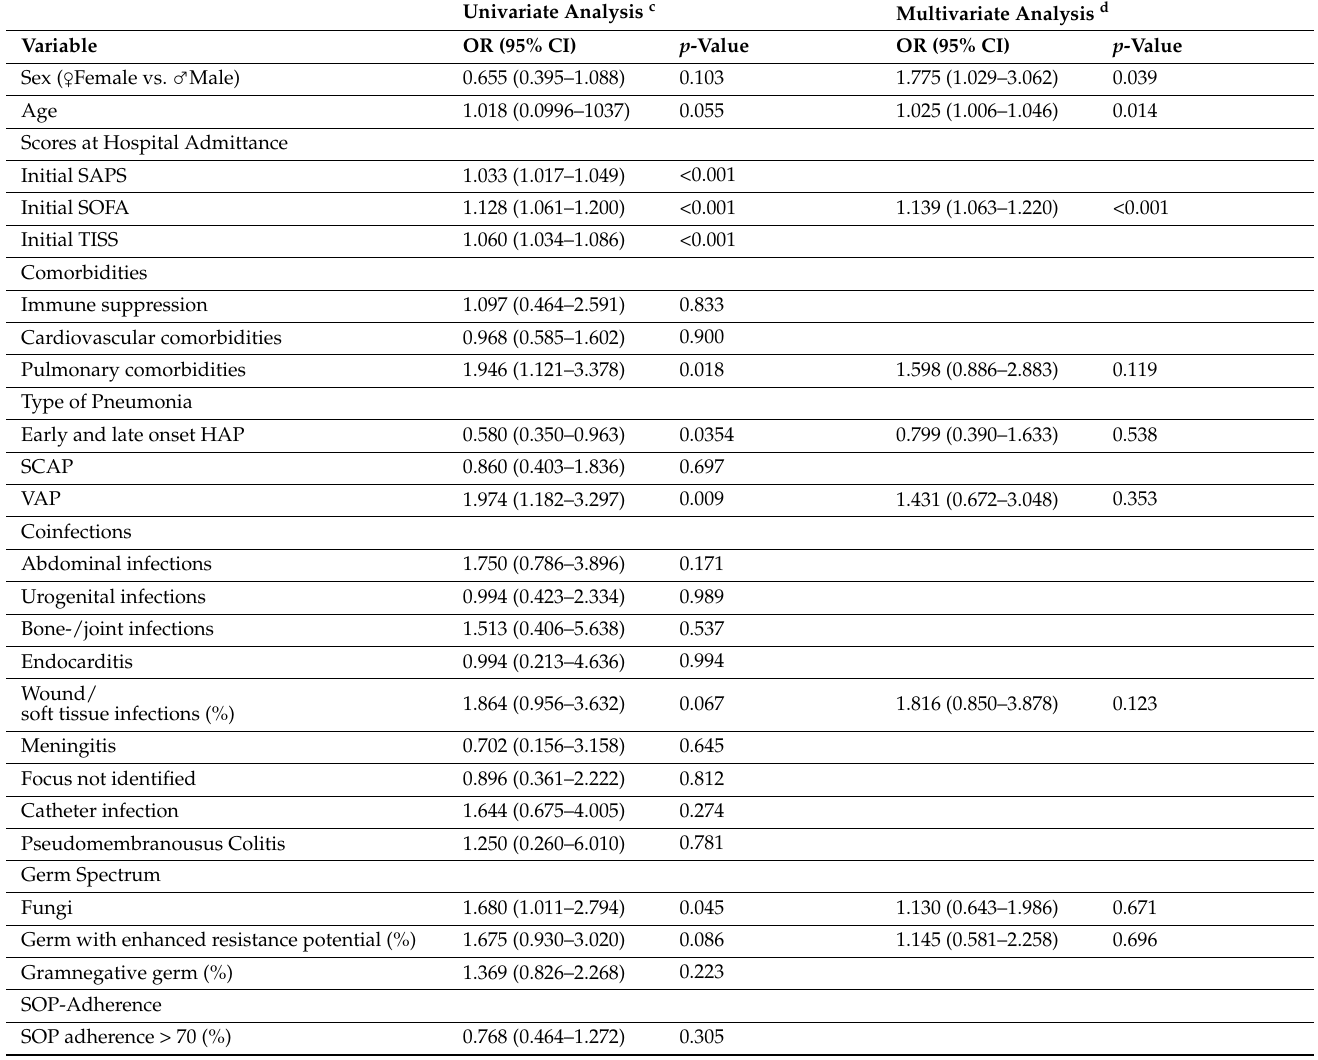
c Left column: Univariate logistic regression for explanation of the influence of different parameters on ICU mortality. d Right column: Multivariate logistic regression analysis with inclusion of parameters with significant association on intensive care mortality. Odds ratio (OR) and confidence interval (CI) are shown. Hosmer– Lemeshow test p =